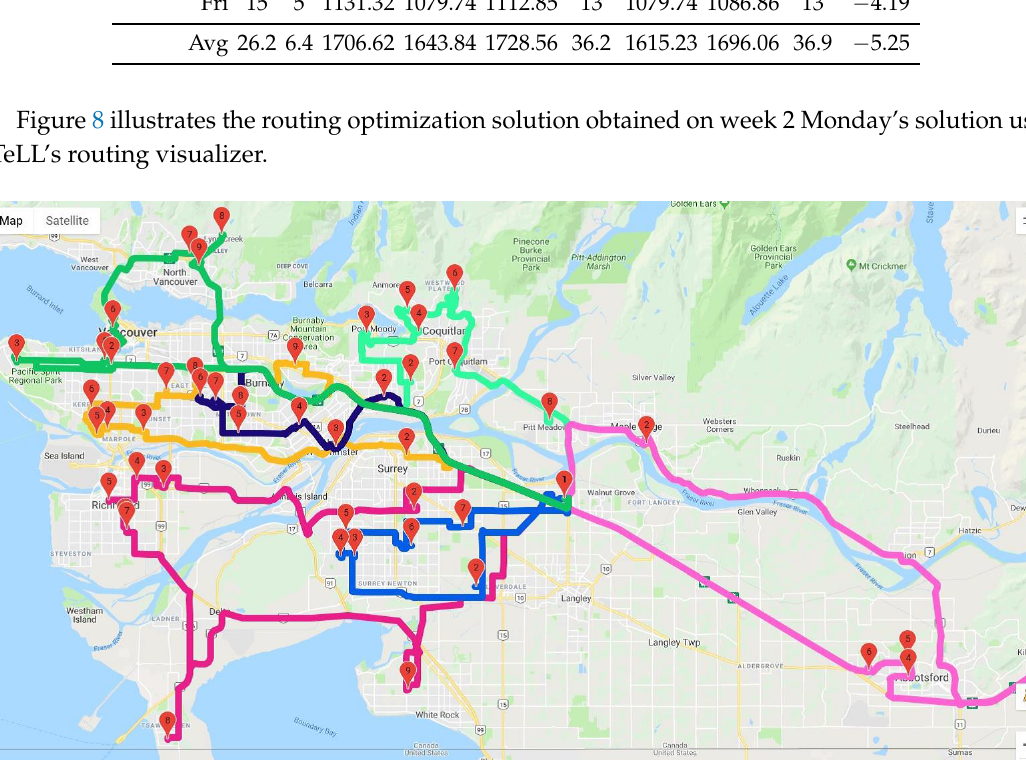
Figure 8. Vancouver and Region routing, Week 2,